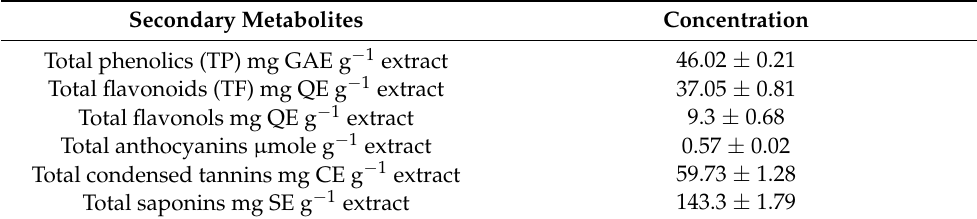
Table 1. Phytochemical analysis of H. persicum shoots.